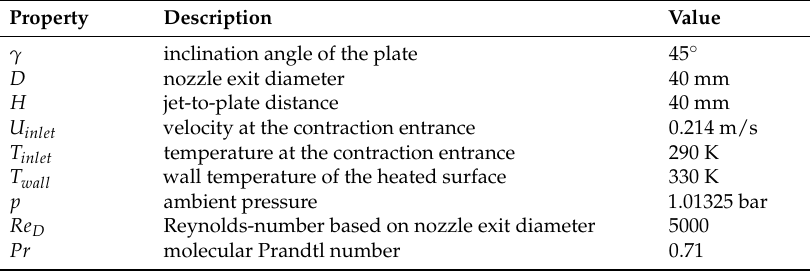
Table 1. Thermal and fluid flow features of the inclined impinging jet